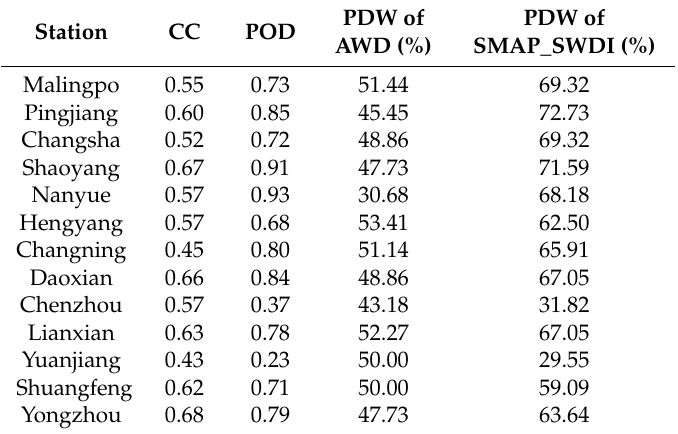
Table 2. Values of CC, POD, and PDWs of AWD and SMAP_SWDI in different